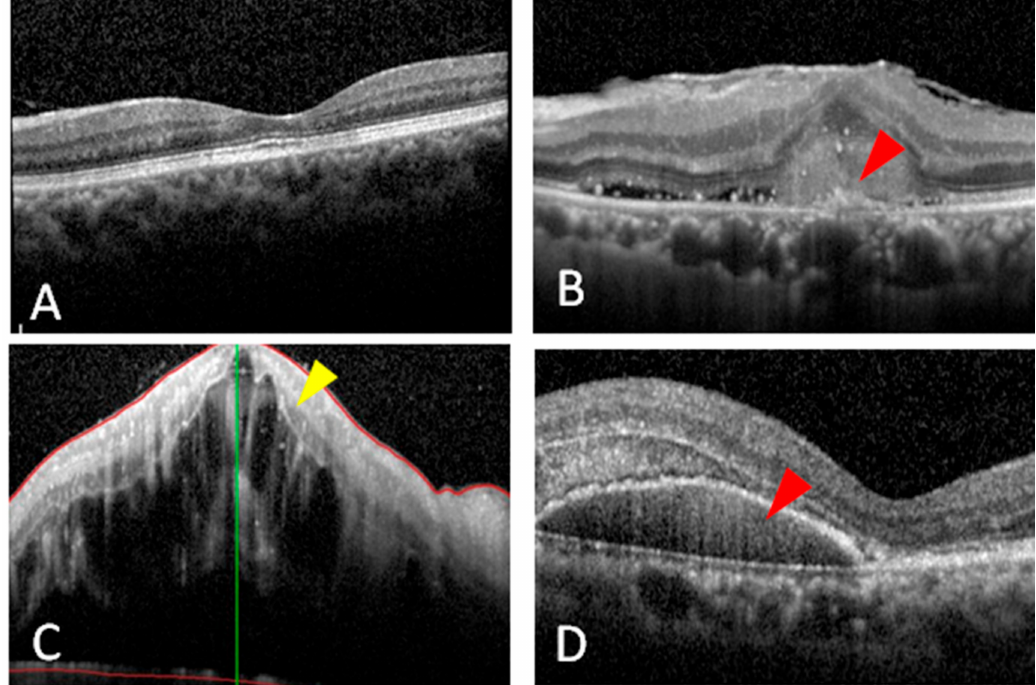
Figure 2. Optical coherence tomography images of the patients with different retinal diseases. ( A ) The image showed a normal macula in the patient with senile cataracts (as the control group). Red arrowheads indicate pigment epithelium detachments and drusen formation in a patient with ( B ) wet age-related macular degeneration and ( D ) polypoidal choroidal vasculopathy. ( C ) The yellow arrowhead shows massive macular edema in a patient with central retinal vein